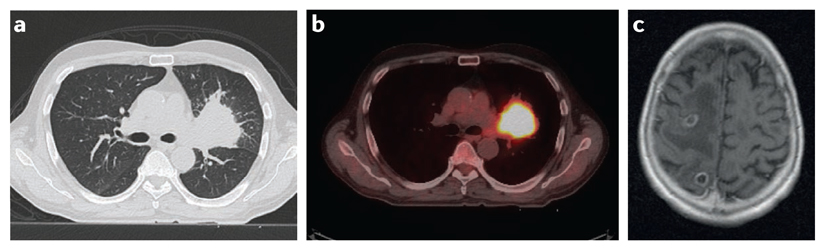
TNM staging of a patient with stage IV non-small-cell lung cancer (T2 N0 M1) identified by a | T2 lung tumour on CT, b | no evidence of local nodal involvement on PET–CT, and c | brain metastases on MRI.